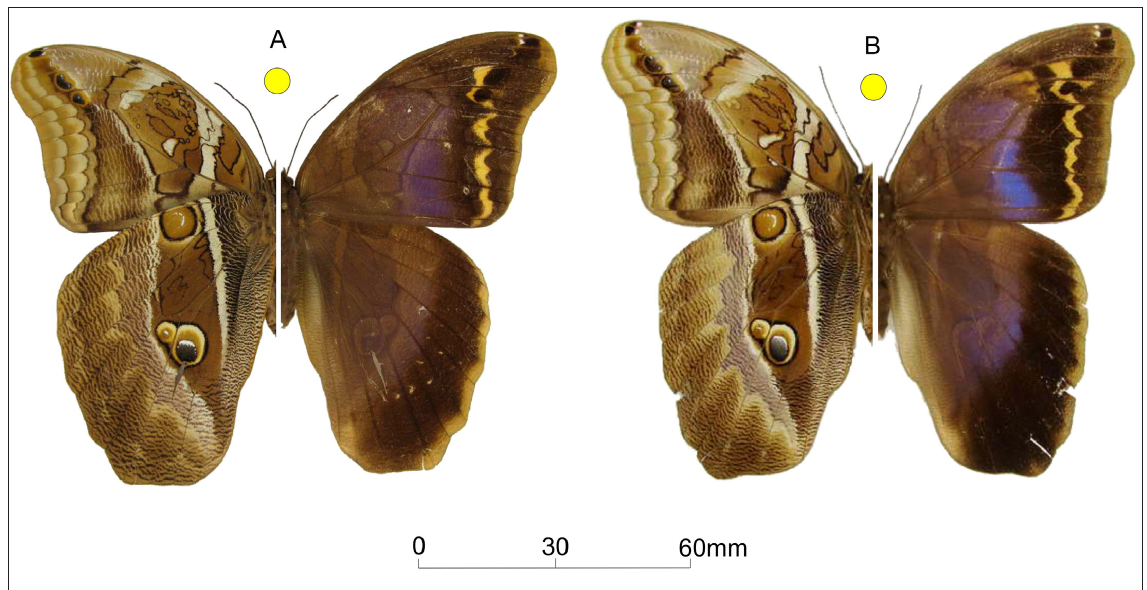
Fig. 8. Habitus of females. Yellow spot: paratype (PT). A . Eryphanis zolvizora reyi ssp. nov., PT (La Chimenea, Barinas, Colombia; MIZA). B . Eryphanis zolvizora isabelae ssp. nov., PT (Colonia Tovar, Aragua, Venezuela; MCC).